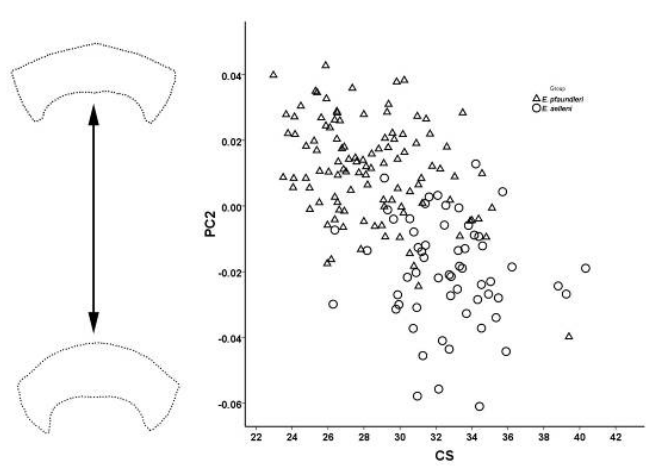
F IGURE 9.- PC2 scores plotted against CS. Species are identified by symbol